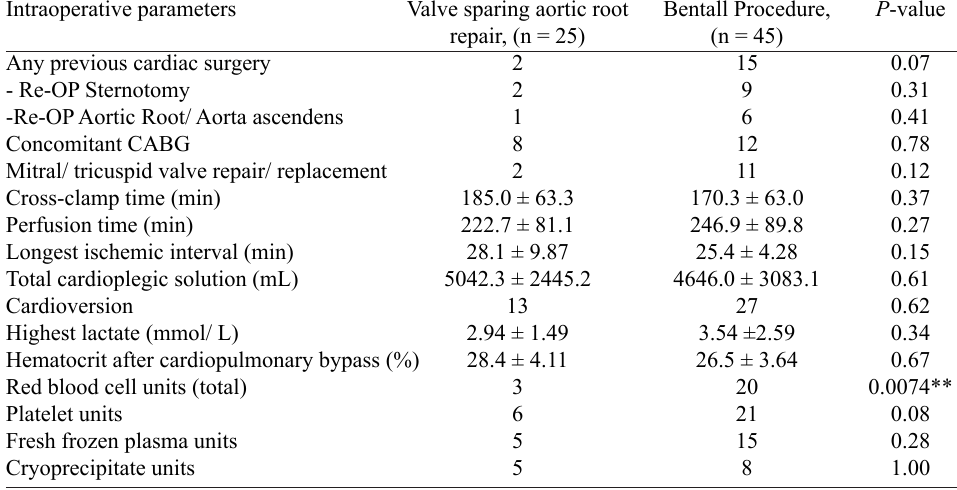
Table 2. Comparing operative parameters